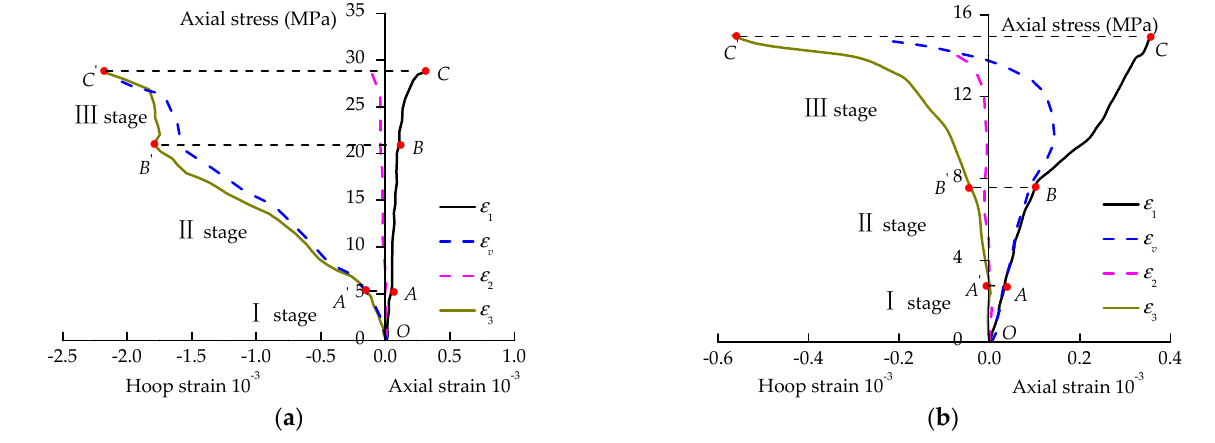
Figure 4. Stress − strain curves under vertical loading: ( a ) Gray samples; ( b ) Cinerous samples.